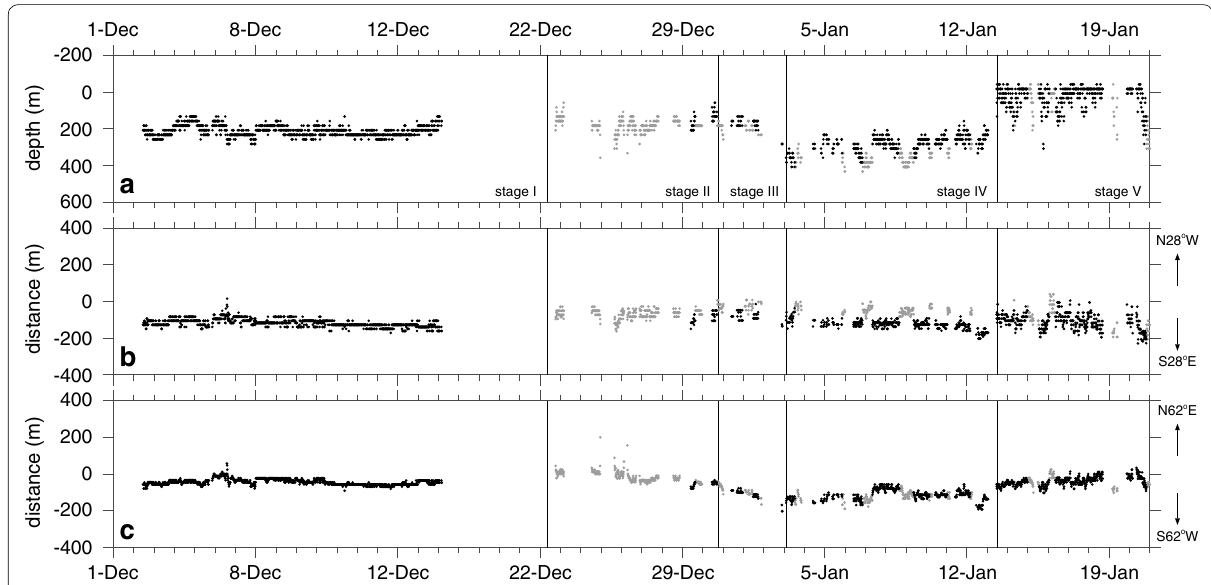
Fig. 8 Time evolution of tremor source locations. a The estimated source depth from the bottom of the crater center is plotted by black (10 station pairs) and gray (six station pairs) dots. The four vertical lines represent the boundaries between each stage. b , c The horizontal locations are plotted in parallel and perpendicular to the strike direction of the crack (Yamamoto et al. 1999). The zero indicates the crater